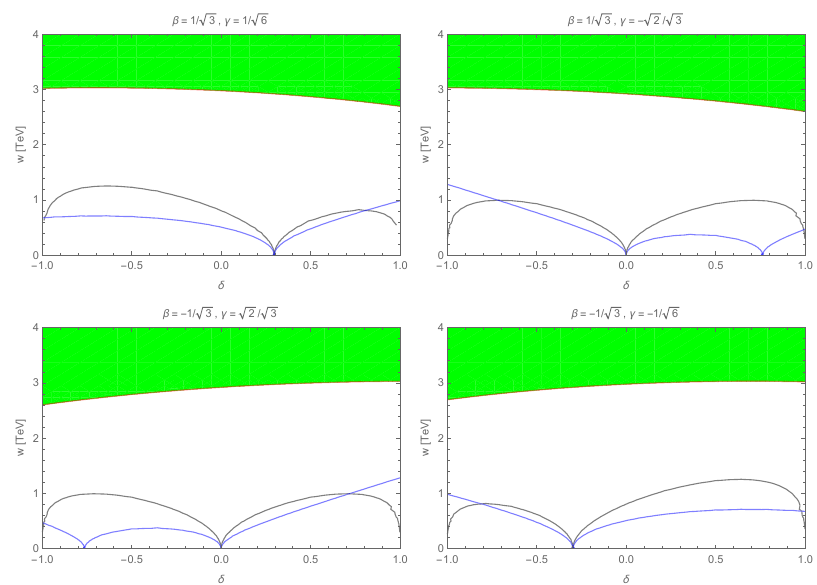
Figure 7 . The bounds on new physics scales as the functions of δ for blue, and black lines correspond to (cid:30) 1 , (cid:30) 2 , (cid:30) 3 for the four kinds of dark matter models ( β = 1 / √ 3 , γ = 1 / √ 6), ( β = 1 / √ 3 , γ = −√ 2 / √ 3), ( β =